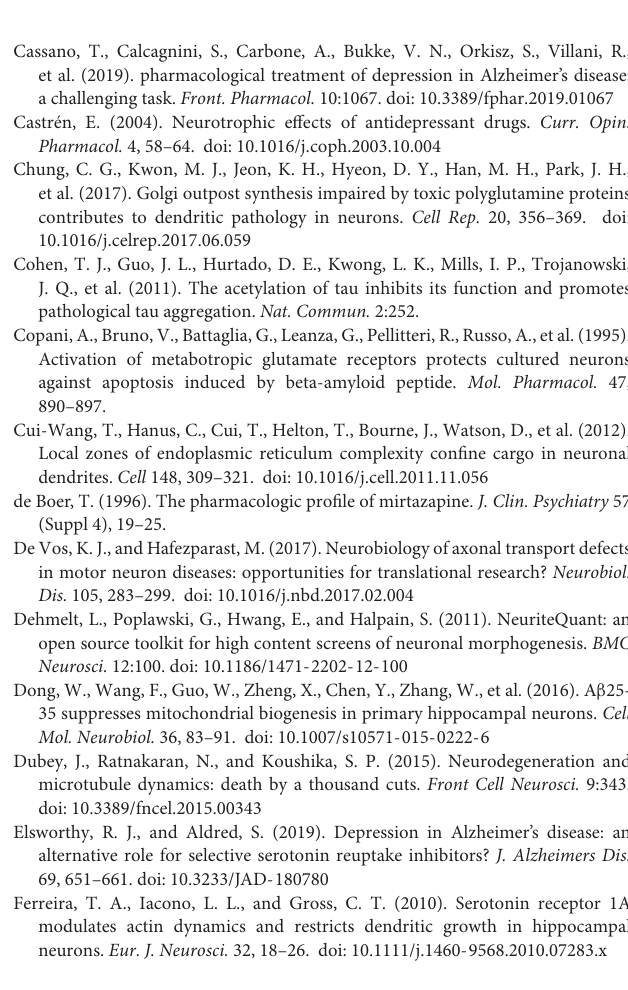
Supplementary Figure 1 | MTT assay dose-curve response of drug and vehicle concentrations on cell survival. Supplementary Figure 2 | Mobility of pGOLT vesicles after DMSO or mirtazapine treatment. (A–C) Examples of time-lapse images of pGOLT vesicles in cultures incubated with vehicle (DMSO) or treated with mirtazapine (MIRTAZ.), under basal conditions or in high KCl medium (post K + ). (D) Quantification of mobility index in the proximal apical, proximal basal dendrites, or high order processes. Supplementary Table 1 | Antibodies used in this